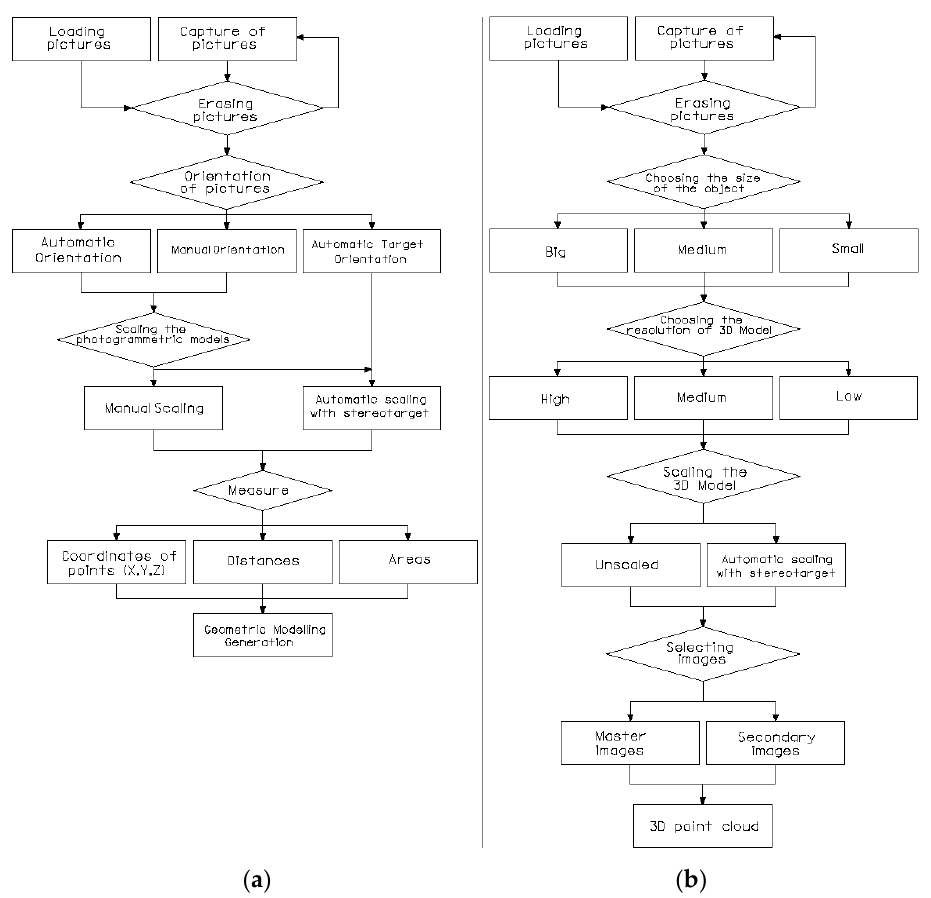
Figure 2. Workflow of EM measurement: ( a ) Photogrammetry; and ( b ) 3D Photomodeling.